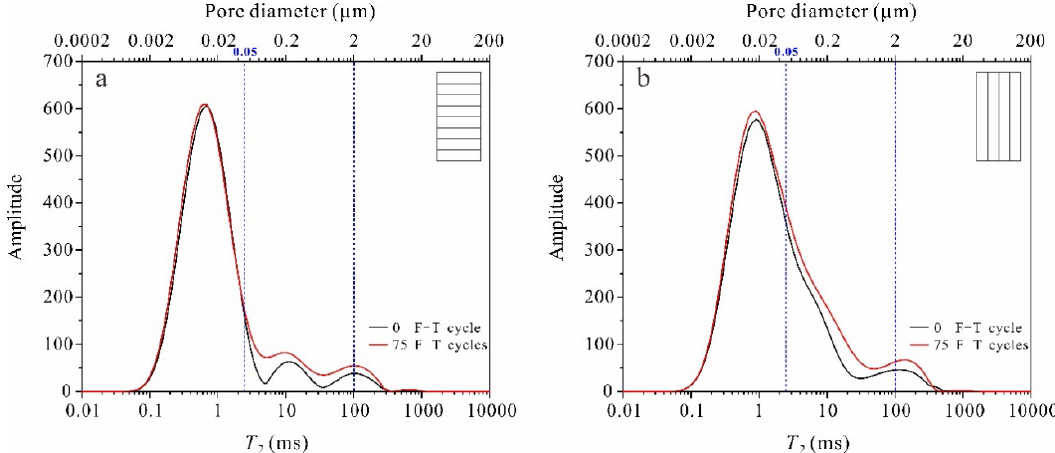
Figure 7. NMR T 2 spectra and pore size distributions before and after F-T cycles in tight sandstone samples with ( a ) perpendicular bedding (S per ) and ( b ) parallel bedding (S par ).